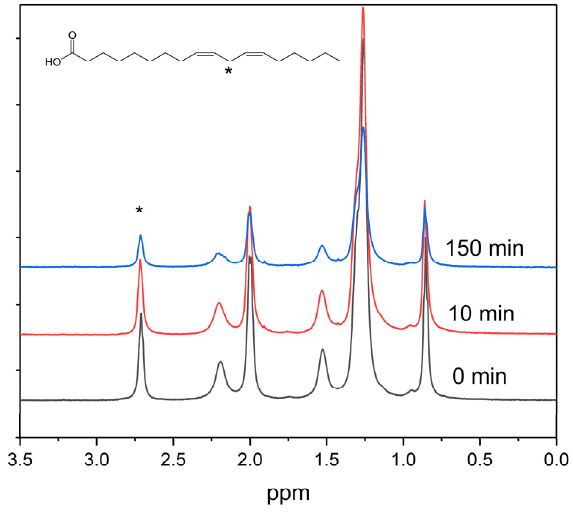
Figure 4. The fragments of 1 H NMR spectra of the initial LA solution (3.5 mM), and at different delay times after the start of the reaction. The signal marked with (*) corresponds to bis-allylic protons of LA.